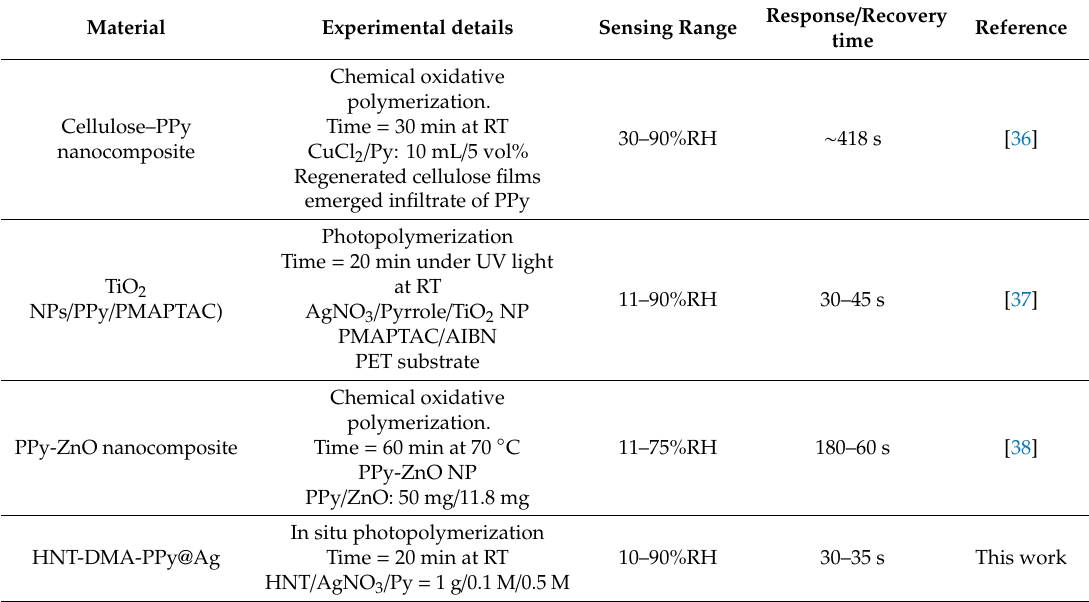
Figure 9. The response and recovery cycle (40–95% RH) of HNT-DMA-PPY@Ag (0.5 wt%) nanocomposite- based impedance sensor. Table 4. Summary of the polypyrrole–NPs based Humidity